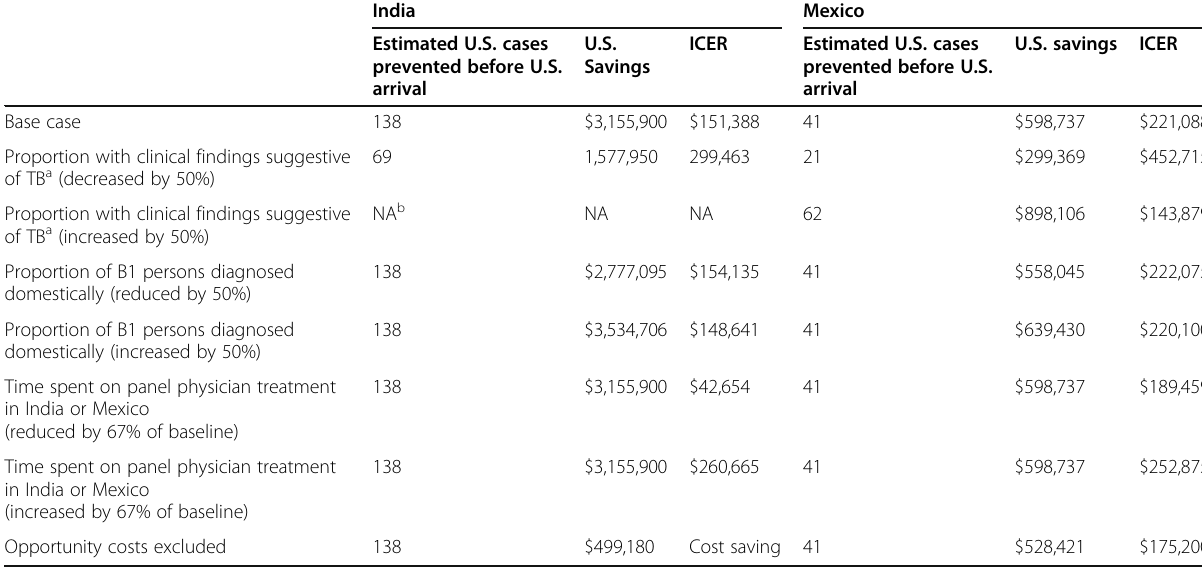
Table 4 One-way sensitivity analyses of the costs of tuberculosis screening of nonimmigrant visa applicants: cost per estimated case averted by varying key parameters, by country